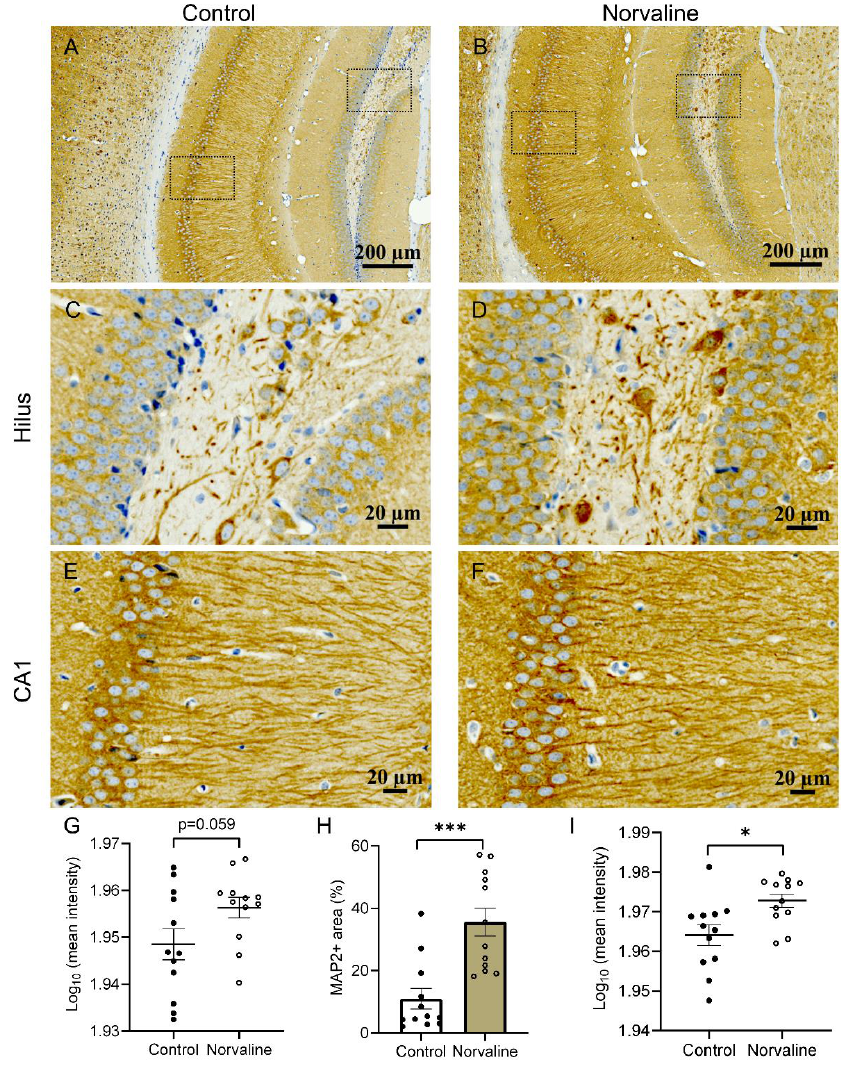
Figure 3. Representative × 20 bright-field micrographs of the 3 × Tg mice hippocampi ( A , B ). × 40 magnification of hilus ( C , D ) and CA1 region ( E , F ). Norvaline treatment led to a significant increase in CA1 MAP2-immunopositive surface area ( H ), and stain intensity ( I ). ( G ) Mean MAP2 stain intensity in hilus area. The data are presented as means ± SEM ( n = 12, four brains per group, three sections per brain). *** p < 0.001, * p < 0.05 (two-tailed Student’s t -test).